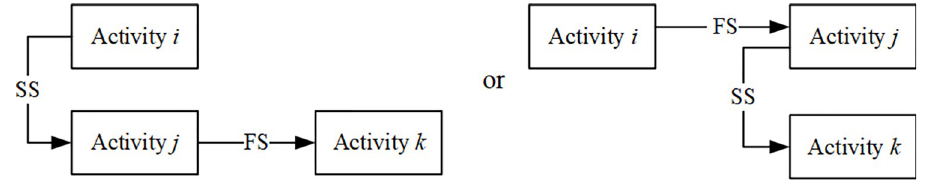
Fig 2. The relationship of